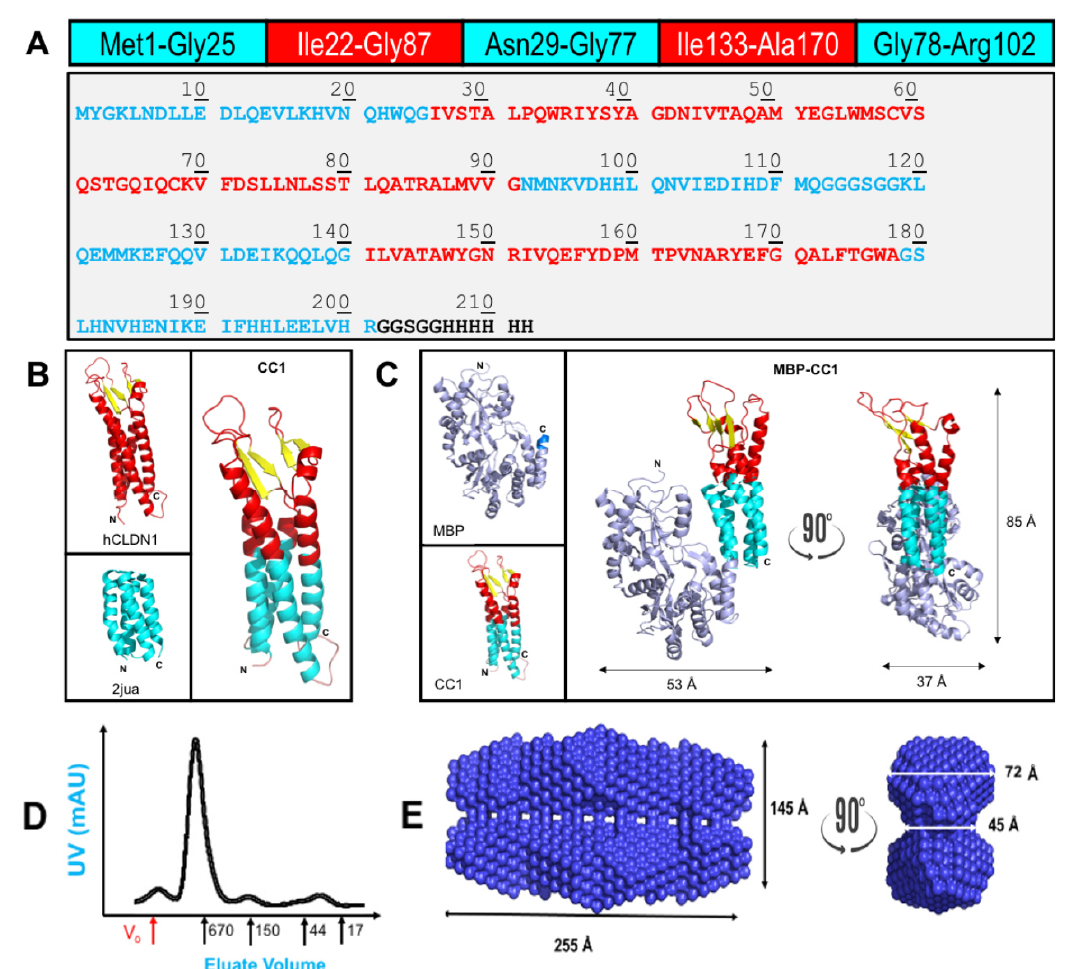
Figure 1. Synthetic design and characterization of MBP-CC1. ( A ) Amino acid composition of CC1. Light blue is soluble protein 2jua and in red is hCLDN1. All chimeric constructs have MBP as N-terminal fusion and a 6xHis tag at the C-terminus. Additionally, we present the full amino acid sequence of the translated CC1. ( B ) Graphical representation of the chimeric design to produce CC1. ( C ) Graphical representation of the chimeric design to produce MBP-CC1. The dimensions of relevant axis of MBP-CC1 are presented. MBP, in light blue, also displays, in dark blue, the position and structure of the short linker of four amino acids (Asn, Ala, Ala, Ala). ( D ) Size-exclusion chromatography of MBP-CC1. The monomeric MBP-CC1 has a molecular weight of 65 kDa. When comparing its elution volume with the protein standards (BioRad Gel Filtration Standard, cat. Number 1511901), MBP-CC1 appears to elute above 670 kDa. Below the x-axis, V o is void volume, and the numbers correspond to standards of molecular weight. ( E ) Small-angle X-ray scattering (bioSAXS) of MBP-CC1 performed at 21 °C. Two different orientations of the volumetric data are presented. bioSAXS data collected for MBP-CC1resulted in a radius of gyration (R g ) of 83.1 ± 4.03, and a maximum particle size (D max ) of 305 Å.